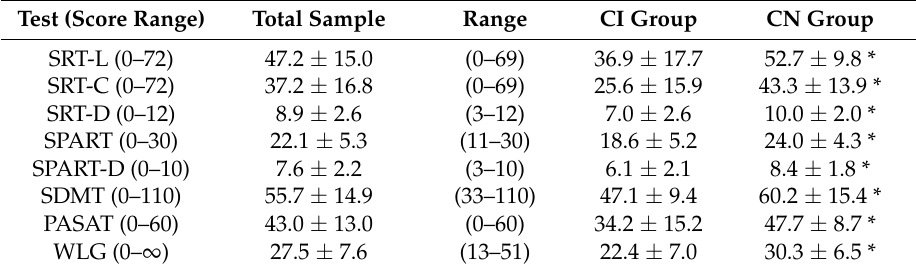
Table 3. Results of the BRBNT cognitive test battery.